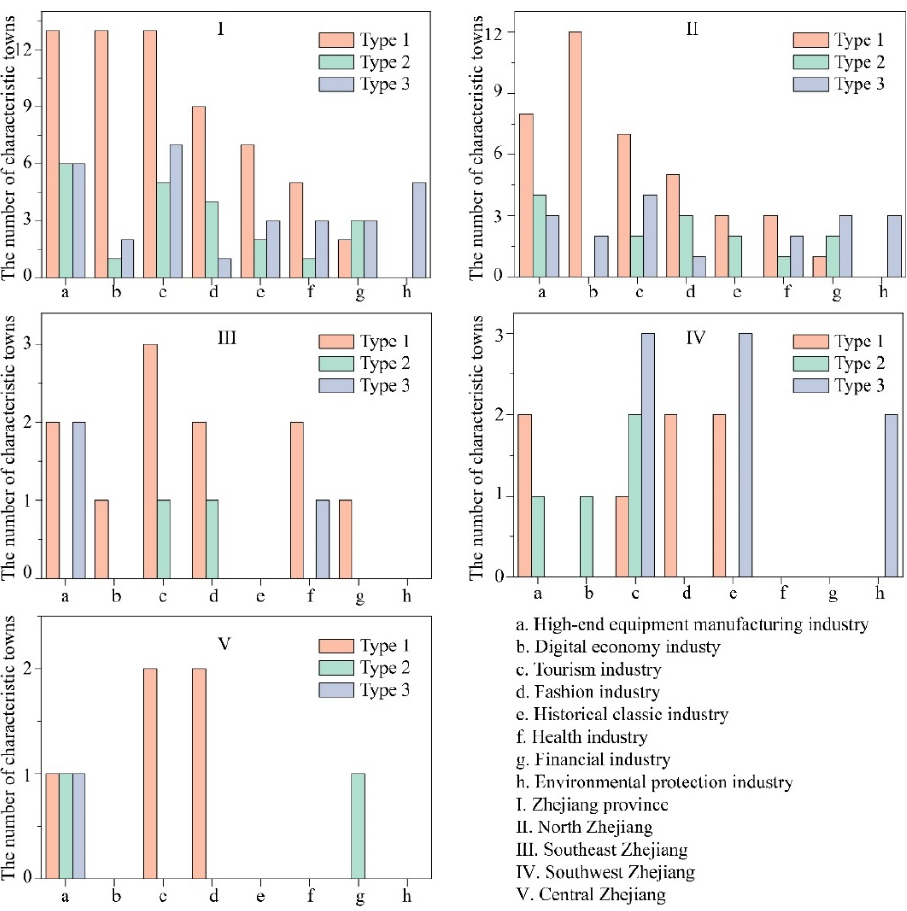
Figure 6. Spatial spillover types in industrial types.